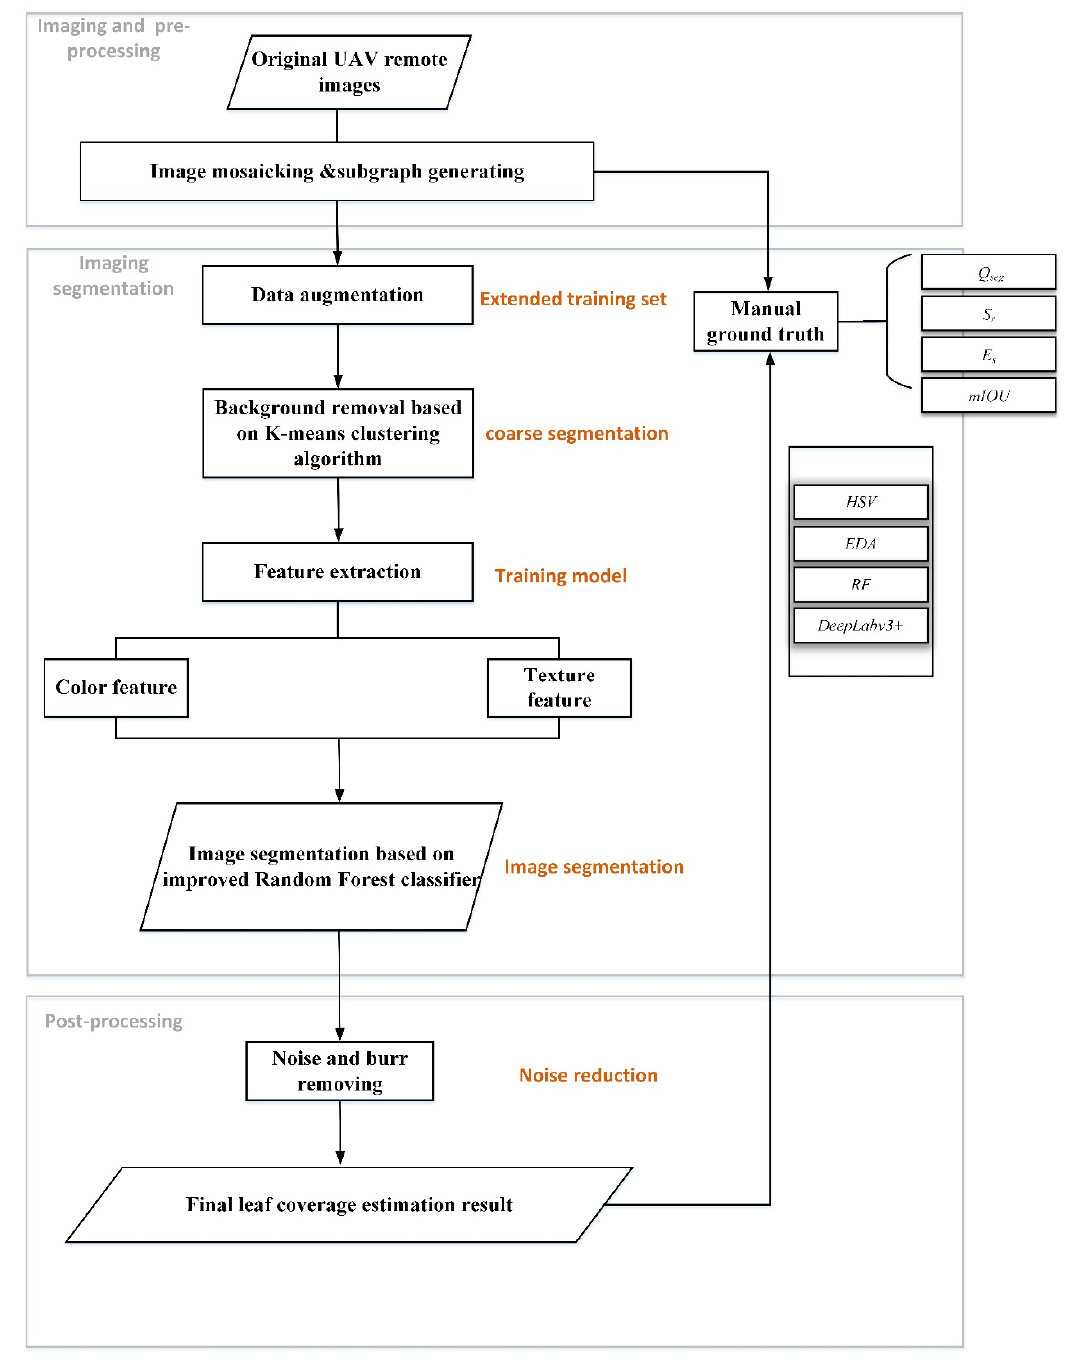
Figure 2. Workflow of a semi-automated method used to estimate leaf coverage.